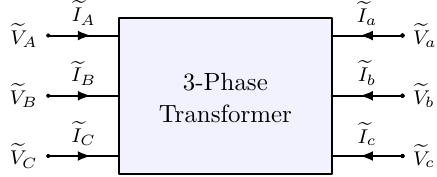
Figure 7. Three-phase transformer component.